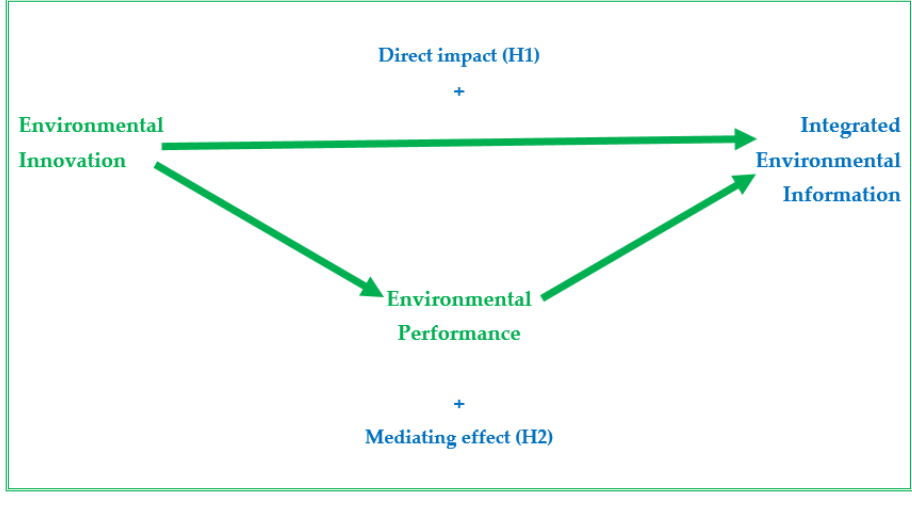
Figure 1. Research